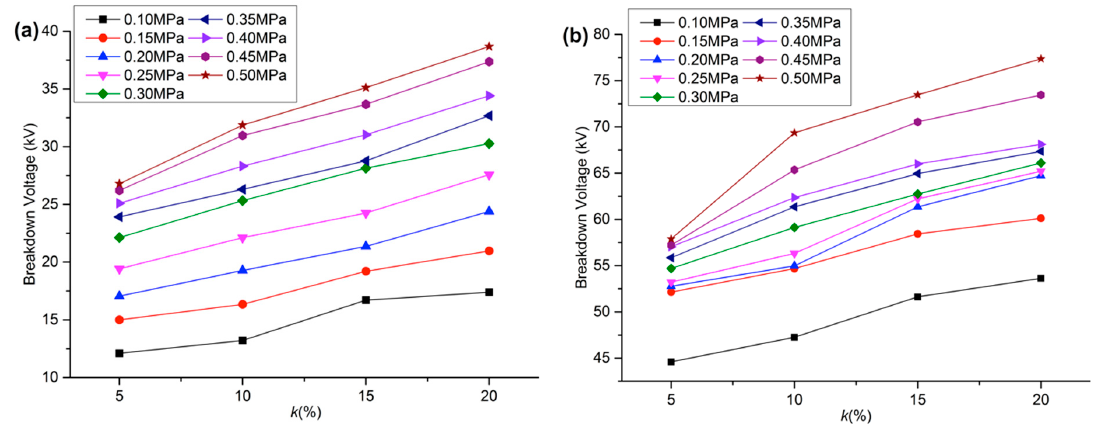
Figure 6. The breakdown voltage of c-C 4 F 8 /N 2 gas varying with the volume fraction for d of ( a ) 5 and ( b ) 15 mm.